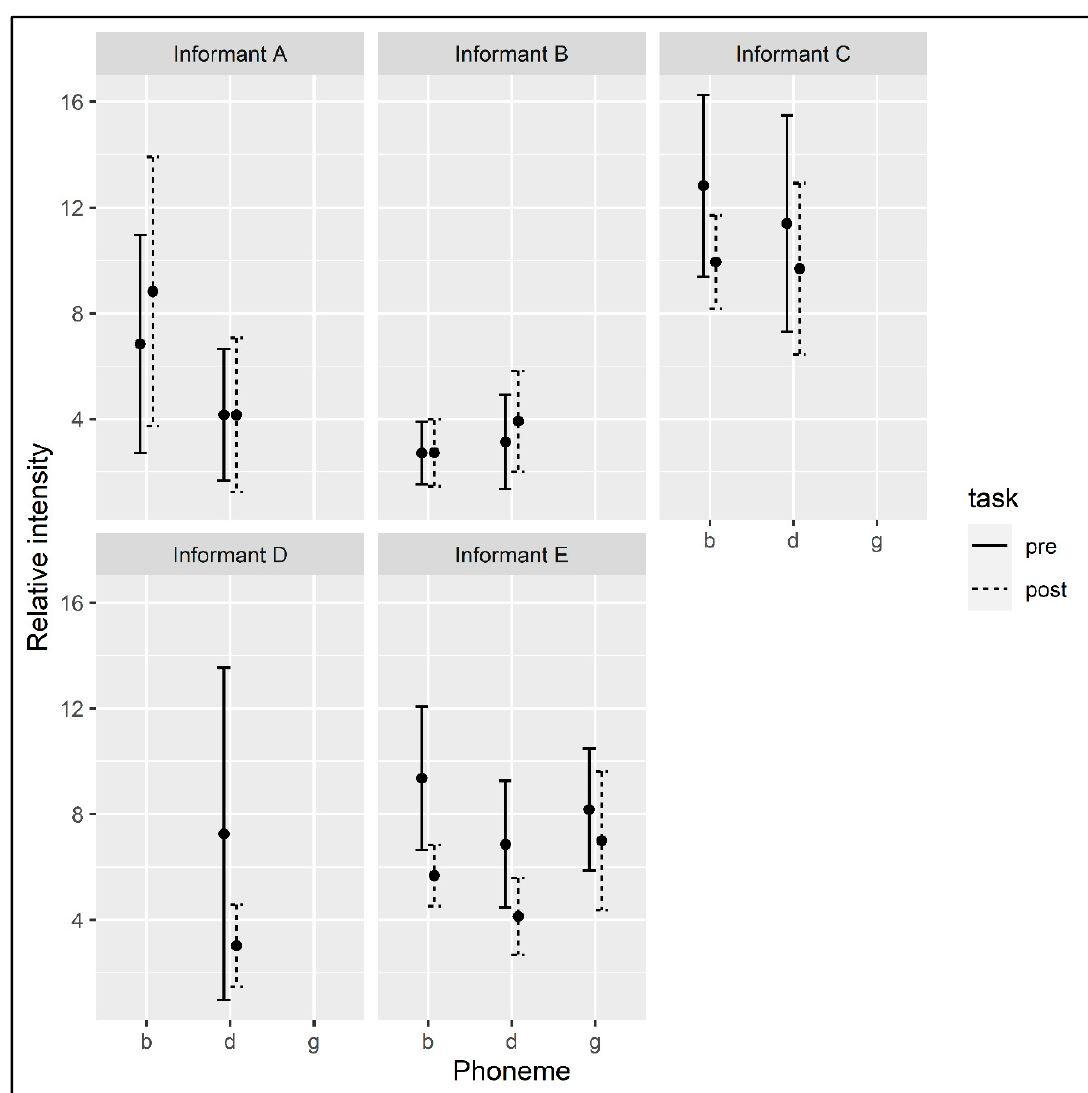
Figure 6. Relative intensity values for pre-semester and post-semester measurements of voiceless consonants for each informant.